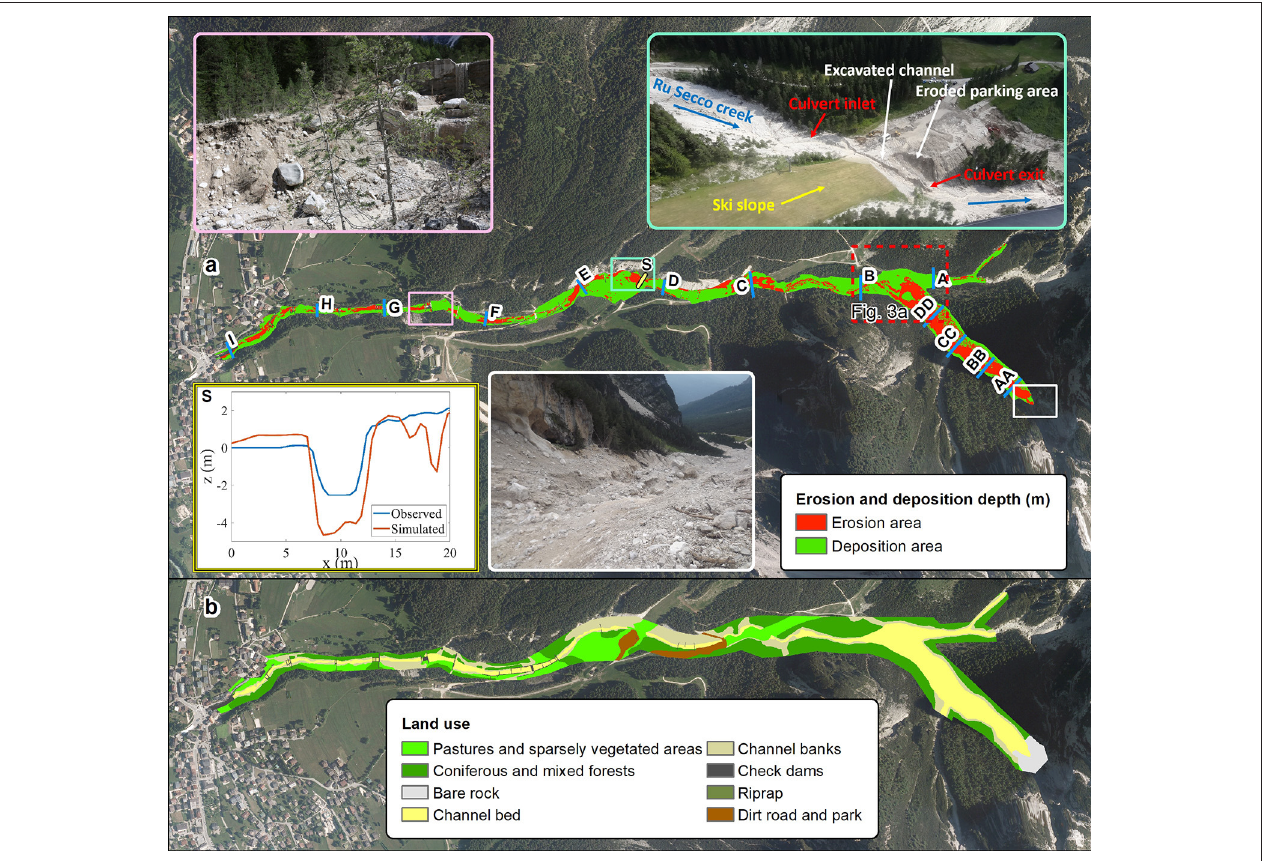
FIGURE 8 | View of the area subjected to deposition or erosion and land use. The upper image (a) is the general view of the areas routed by debris flows and subjected to deposition or erosion. The top right insert is the post-event view of the area depicted in Figure 3b while the other three inserts show the downstream view of debris flow route incising the debris material covering the Ru Salvela creek (bottom middle), the observed and simulated cross-section of the channel excavated by debris flow above the culvert (bottom left) and a particular of a bank erosion after the upper culvert (top left). The position of the cross-sections that are shown in the Supplemental Materials is also indicated. The lower image (b) is the landuse of terrain for the routing